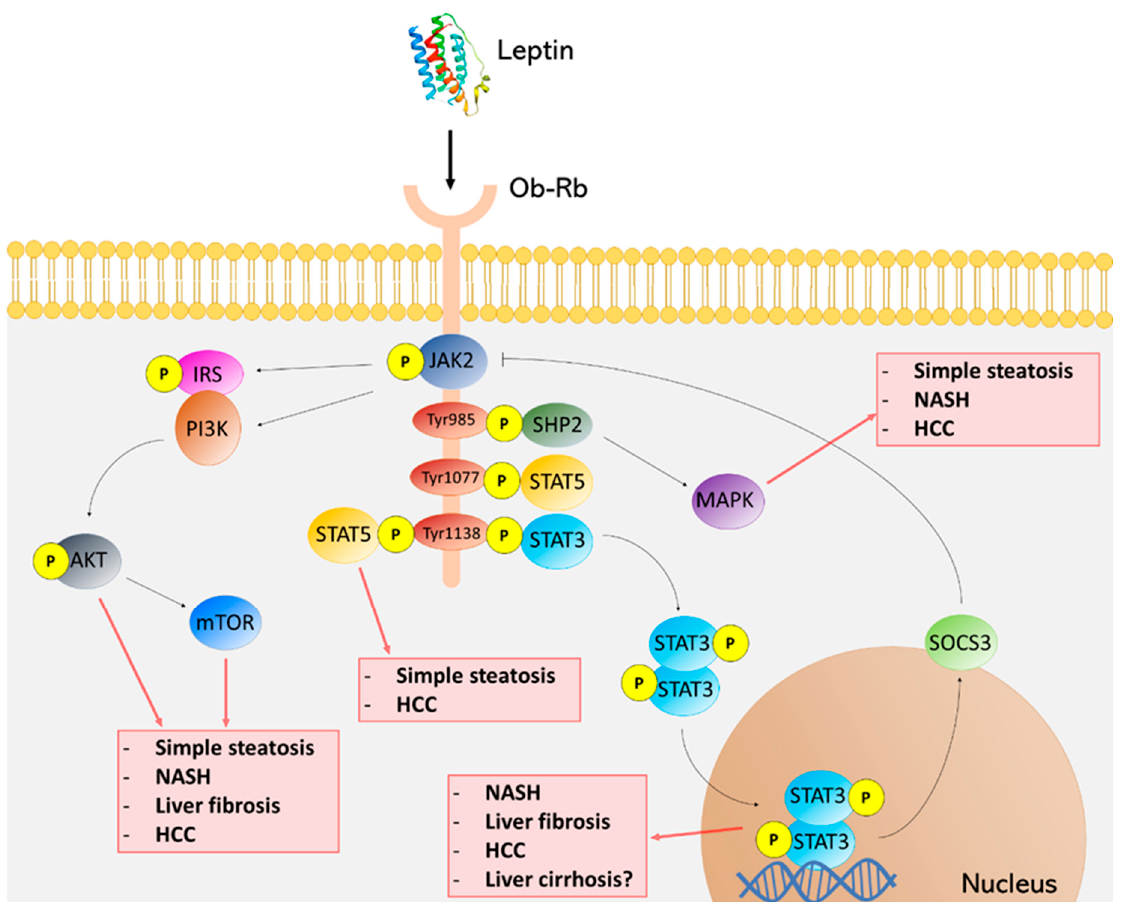
Figure 1. Leptin signaling pathways in the NAFLD spectrum. Leptin/Ob-Rb interaction activates different pathways via JAK2 phosphorylation. The consequent signaling cascade can exert a disruptive role through the activation and phosphor- ylation of some component implied in this signaling network, such as signal transducer and activator of transcription (STAT)3, STAT5, mitogen-activated protein kinase (MAPK) or AKT/mammalian target of rapamycin (mTOR) pathways, thus favoring some malignancies of the NAFLD spectrum.